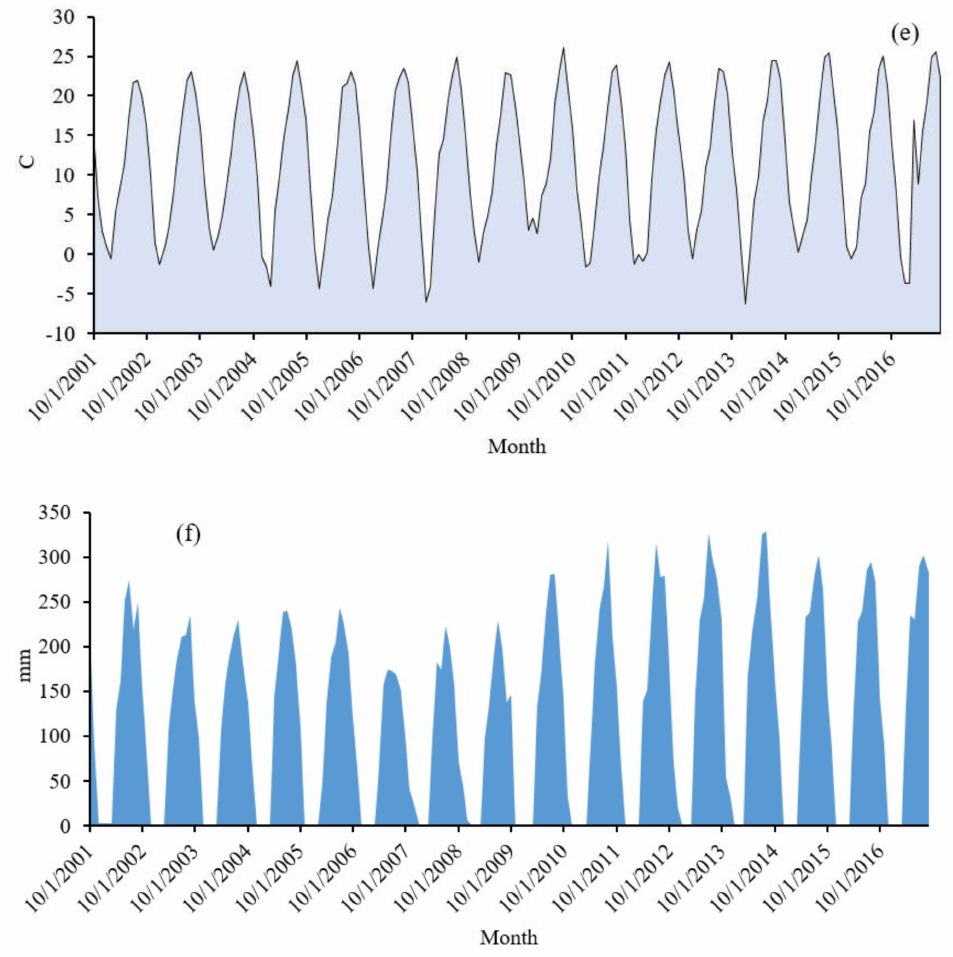
Figure 2. Monthly time series of observed variables from 2001 to 2017, ( a ) river flow, ( b ) groundwater withdrawal of observation well P1, ( c ) groundwater withdrawal of observation well P2, ( d ) precipita- tion, ( e ) temperature, and ( f )